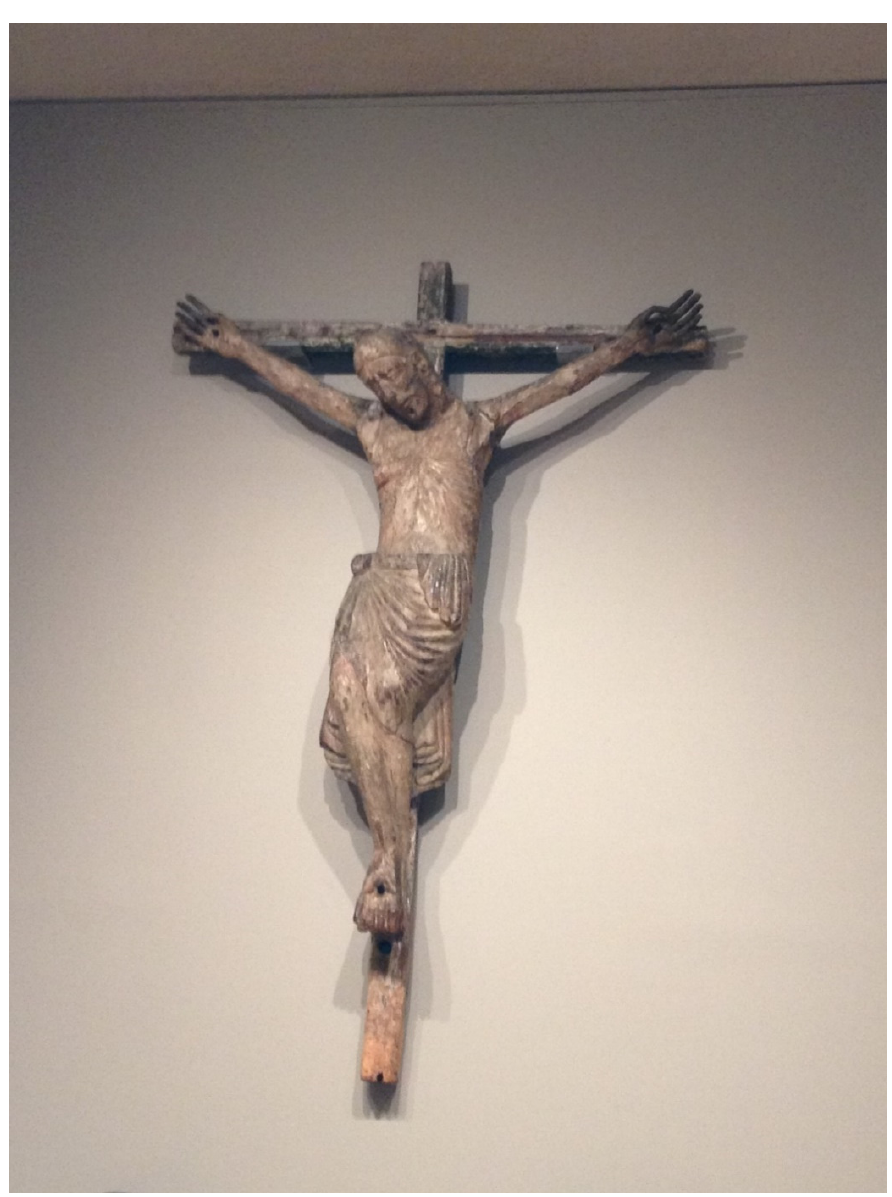
Figure A2. Crucifix, unknown Spanish, early 13th century. Source: 52. 34 Memorial Art Gallery of the University of Rochester (Photograph taken by the author.).